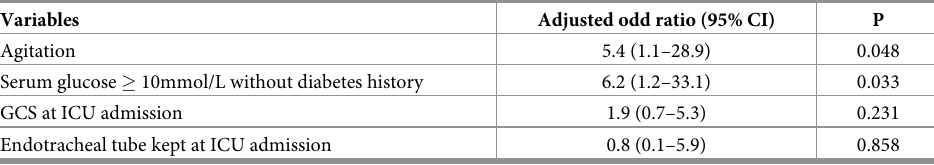
Table 7. Risk factors for unfavorable functional neurologic outcome (adjusted analysis).